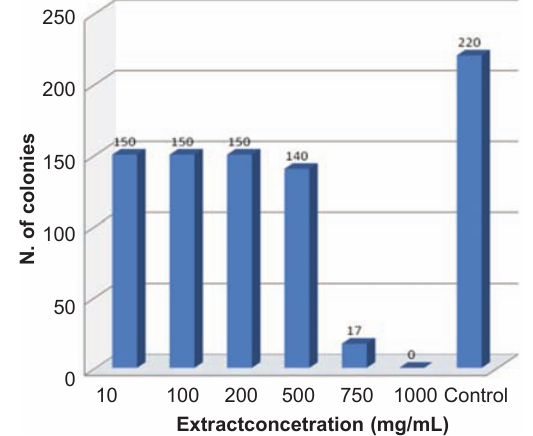
Figure 1. Colony characteristics of H. pylori on Brucella agar medium supplemented by 10% sheep blood and antibiotics.